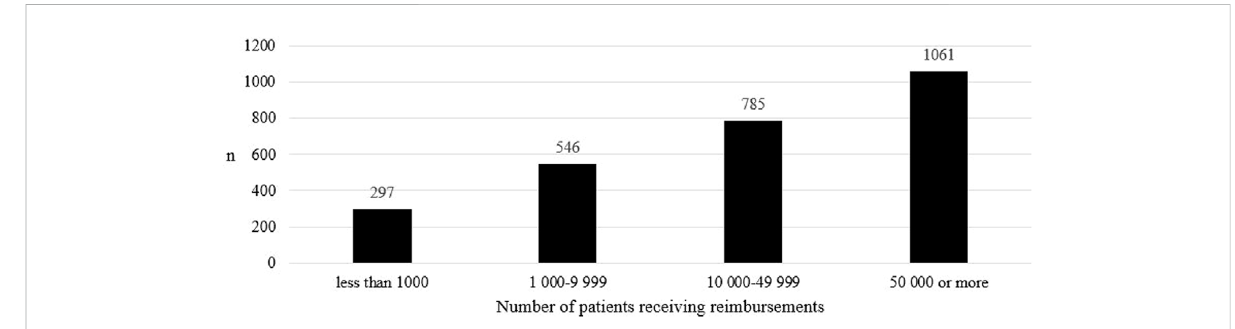
FIGURE 3 The number of medicine shortages in Finland from 2017 to 2019 in groups including at least one reimbursable product ( N = 382) according to the number of patients receiving reimbursements in Finland in 2022.